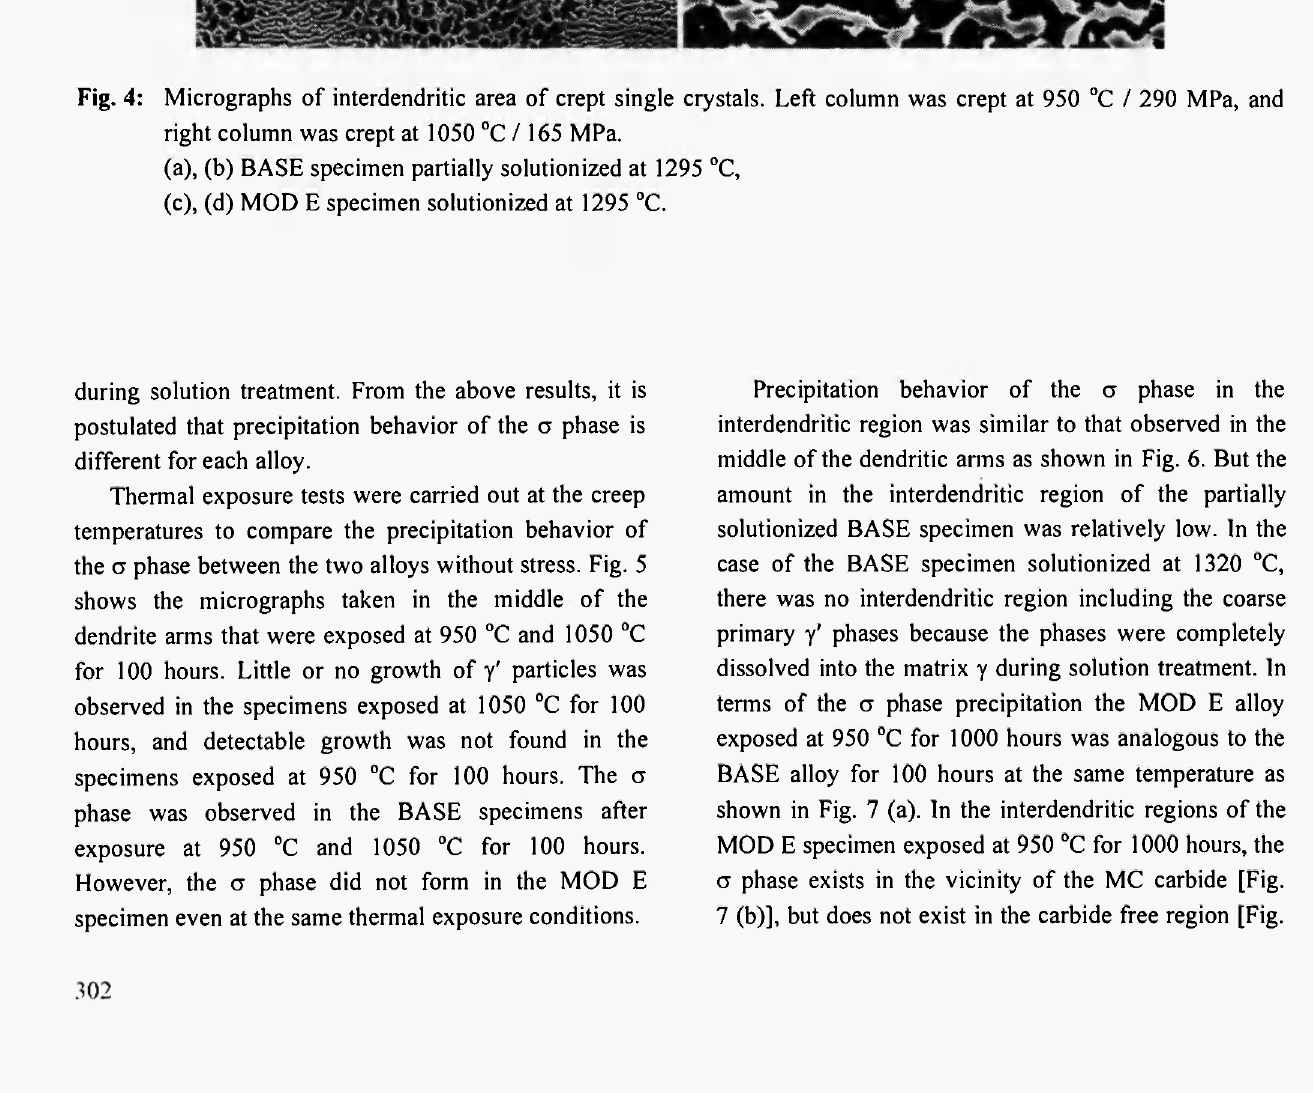
Fig. 4: Micrographs of interdendritic area of crept single crystals. Left column was crept at 950 °C / 290 MPa, and right column was crept at 1050 °C /165 MPa. (a), (b) BASE specimen partially solutionized at 1295 °C, (c), (d) MOD Ε specimen solutionized at 1295